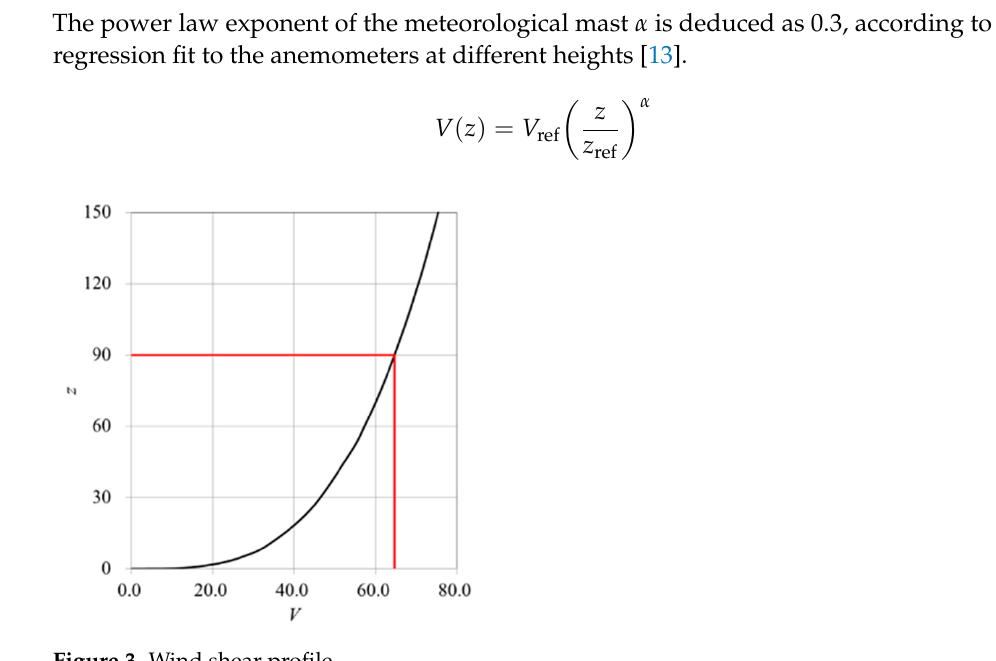
Figure 3. Wind shear profile.